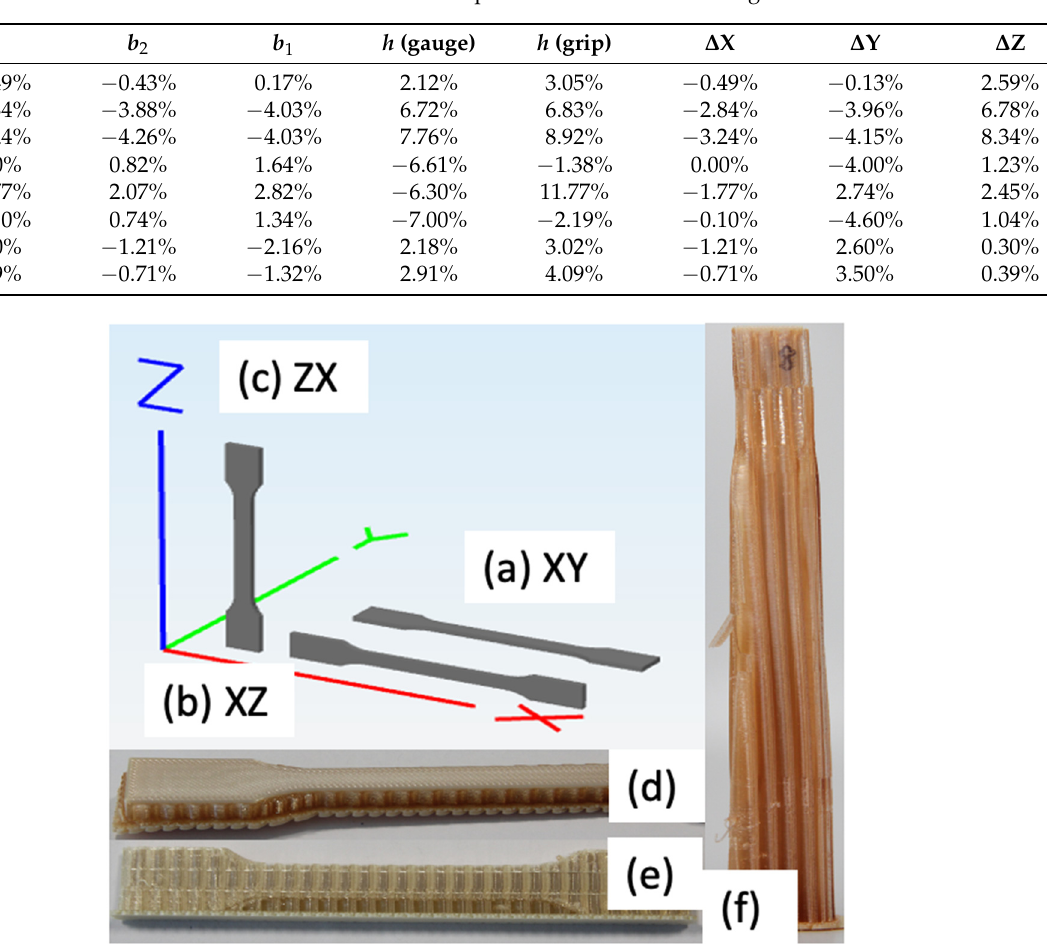
Figure 6. Effect plot for change in dimensions in the ( a ) X direction, ( b ) Y direction, and ( c ) Z direc- tion. In general, the print direction of the coupons has the most significant impact on the change in dimensional. From Figure 6a, the coupons shrunk in length in the X direction, by an average of 1.05%. It is observed that the higher the annealing temperature, and